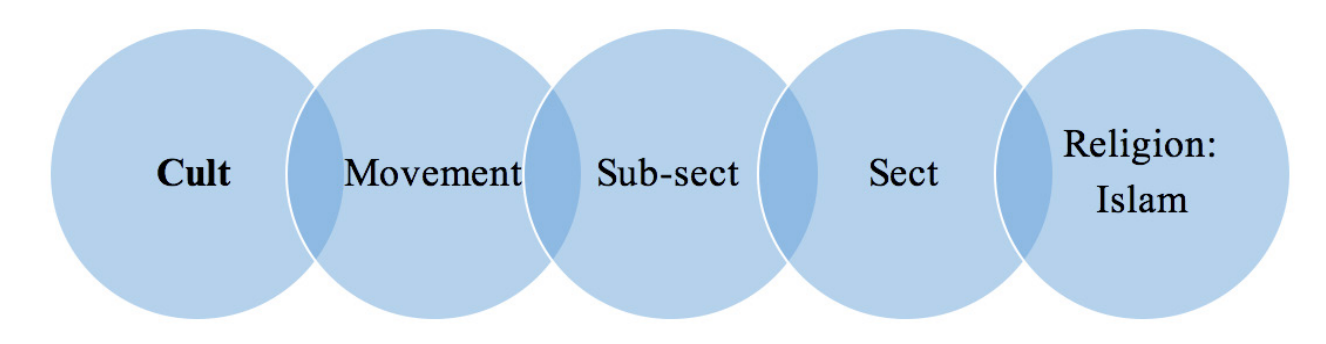
Figure 2: Islamic-based typological continuum from cult to